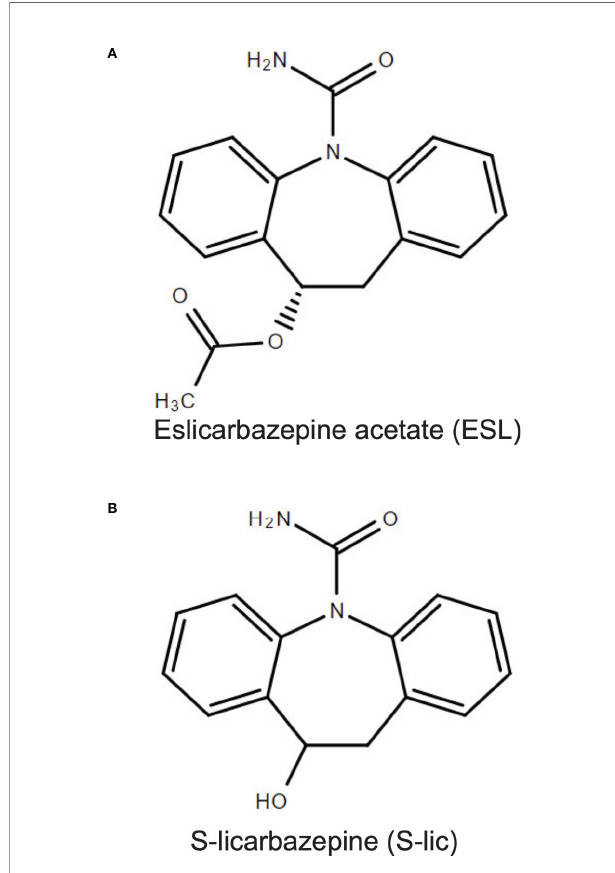
FIGURE 1 | Chemical structures of eslicarbazepine acetate and S- licarbazepine. (A) eslicarbazepine acetate; (9S)-2-carbamoyl-2-azatricyclo [9.4.0.0 38 ]pentadeca-1 (15),3,5,7,11,13-hexaen-9-yl acetate. (B) S- licarbazepine; (10R)-10-hydroxy-2-azatricyclo[9.4.0.0 3,8 ]pentadeca-1 (11),3,5,7,12,14-hexaene-2-carboxamide. Structures were drawn using Chemspider